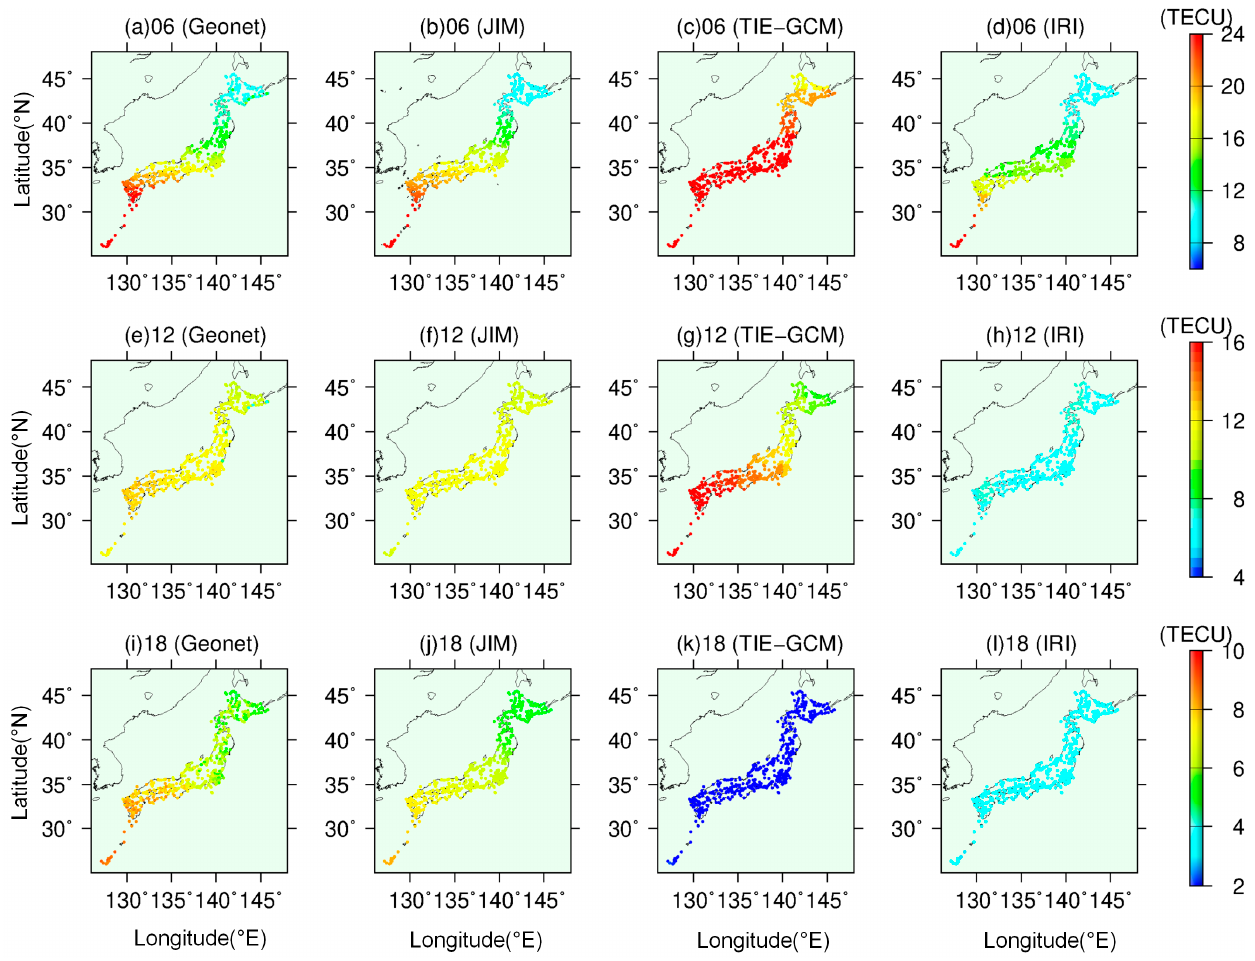
Figure 9. Similar to Figure 8, but on 8 September 2017 when the solar wind speed exceeded 800 km/s and the Dst value dropped to − 142